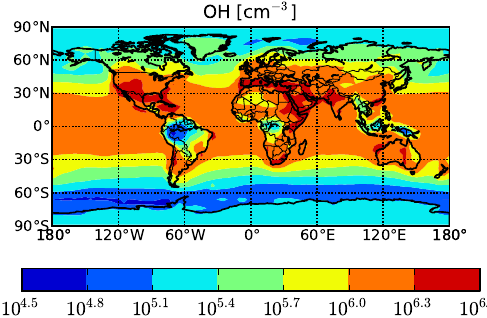
Fig. 4. Annual-mean boundary-layer OH concentrations in the BBASE